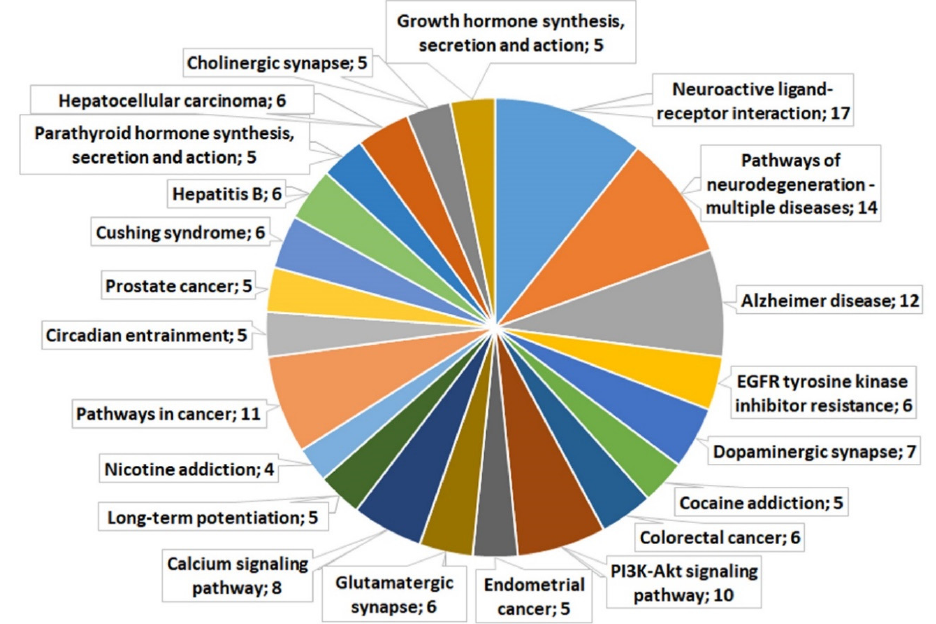
Figure 2. KEGG pathways for the 72 genes associated with neurogenesis and found to be differentially expressed in our comparison of the hippocampal transcription profile between control male mice and males with consecutive 20 days of wins in daily agonistic interactions.